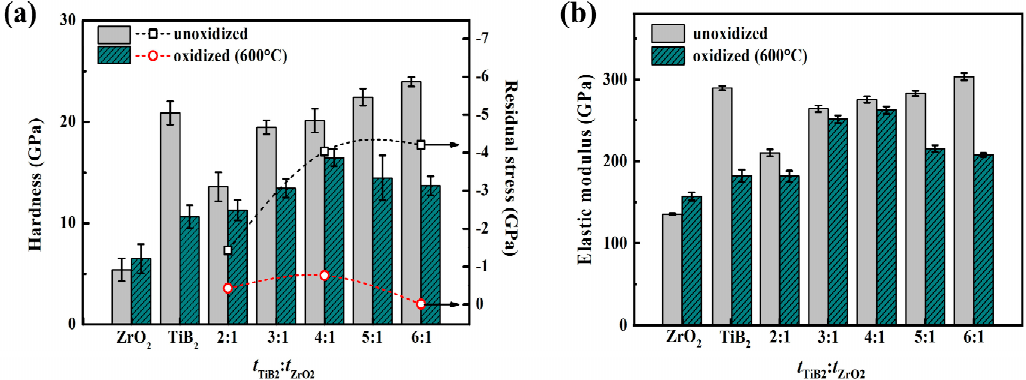
Figure 7. The hardnes, residual stress ( a ), and elastic modulus ( b ) of the TiB 2 and ZrO 2 monolayers and the TiB 2 /ZrO 2 multilayers with different t TiB ₂ : t ZrO ₂ before and after annealing.